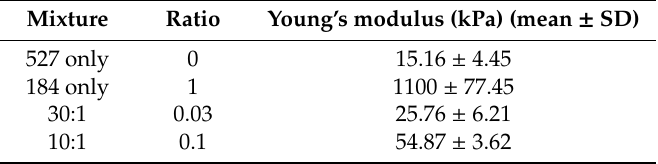
Table 1. Microsca ff old sti ff ness measurements. Mean + SD (three samples, three locations, except for 527 only and 30:1, as the viscosity, only allowed for three measurements in